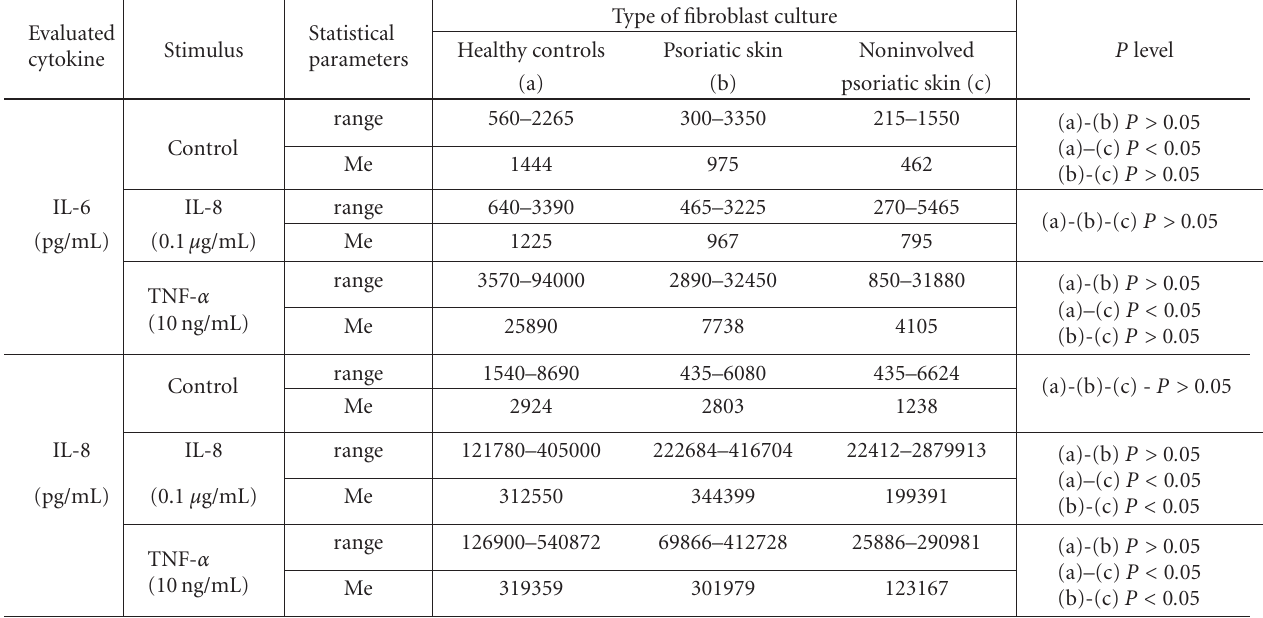
Table 2: Comparison of IL-6 and IL-8 levels in supernatants obtained from cultures of di ff erent types of fibroblasts. (a) Healthy controls: fibroblasts from normal skin of healthy volunteers; (b) psoriatic skin: fibroblasts from lesional skin of psoriatic patients; (c) noninvolved psoriatic skin: fibroblasts from perilesional skin of psoriatic